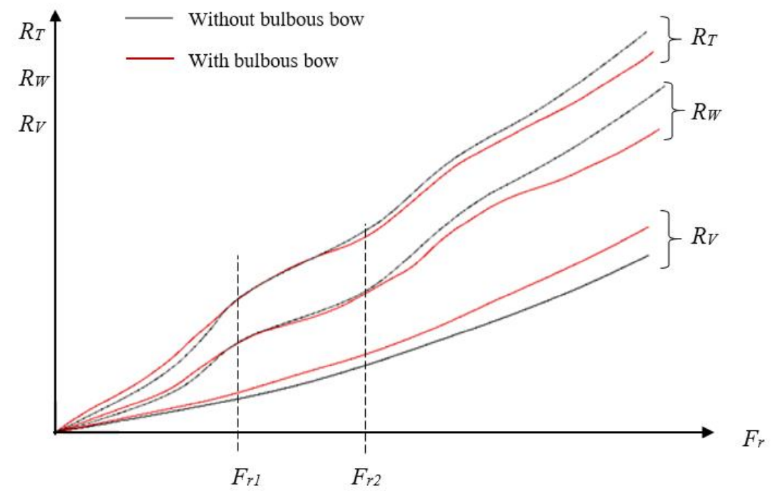
Figure 6. The influence of bulbous bow on the components of the ship’s total resistance in the function of Froude number, where: F r